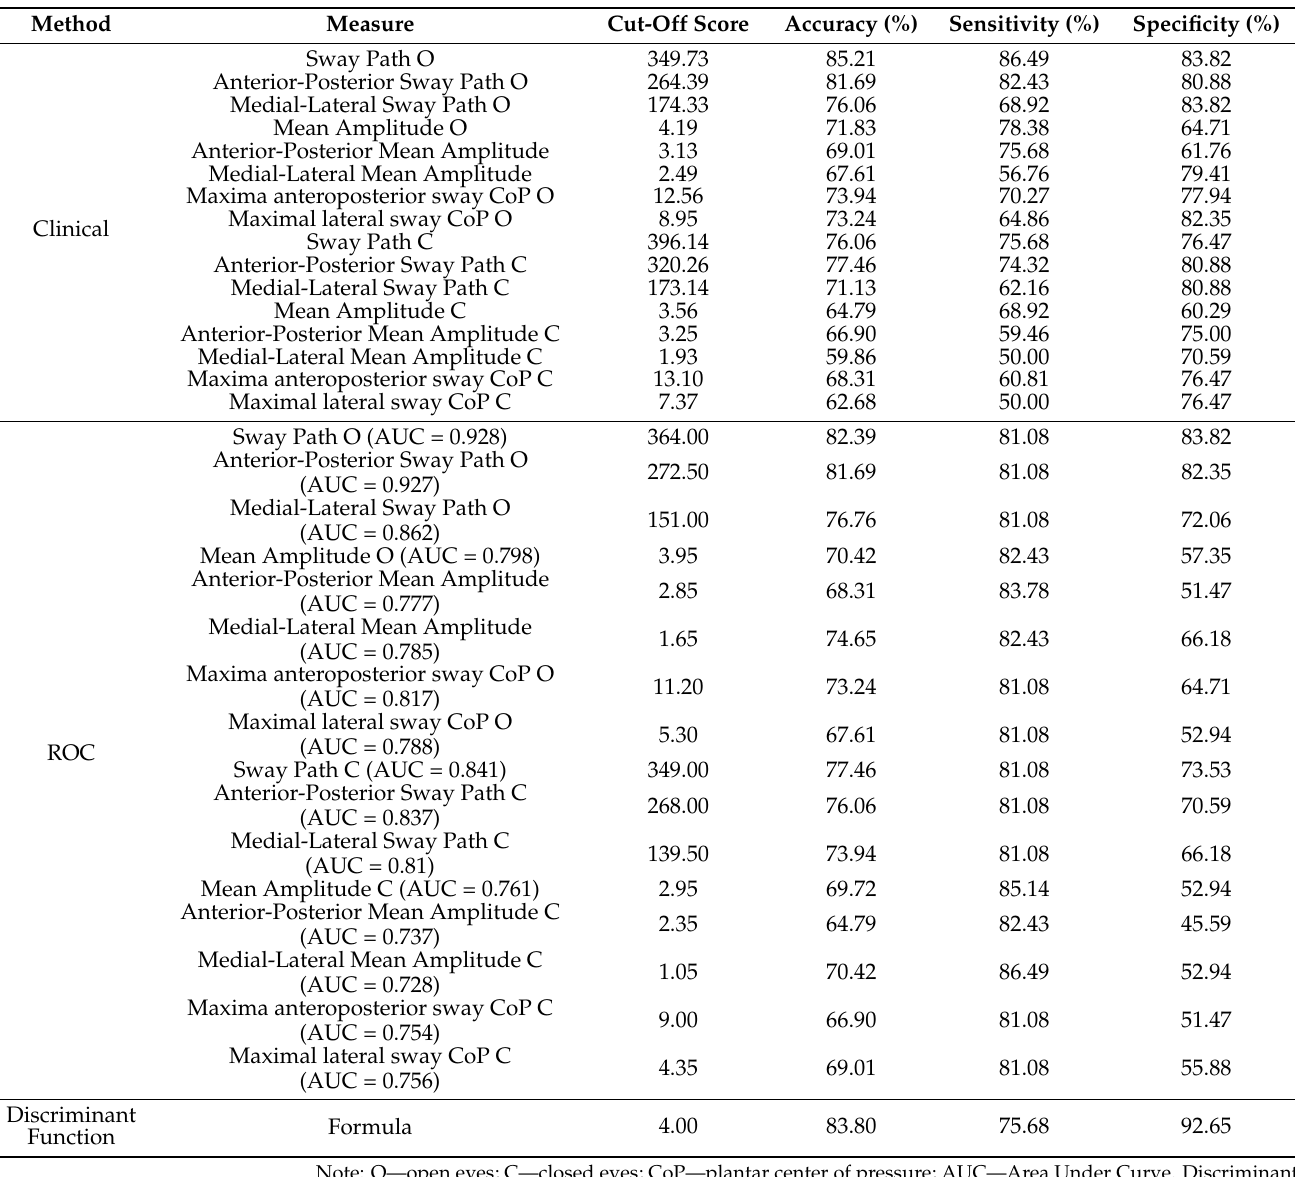
Table 4. Clinical, ROC, and discriminant function cut-off scores for a high risk for falling